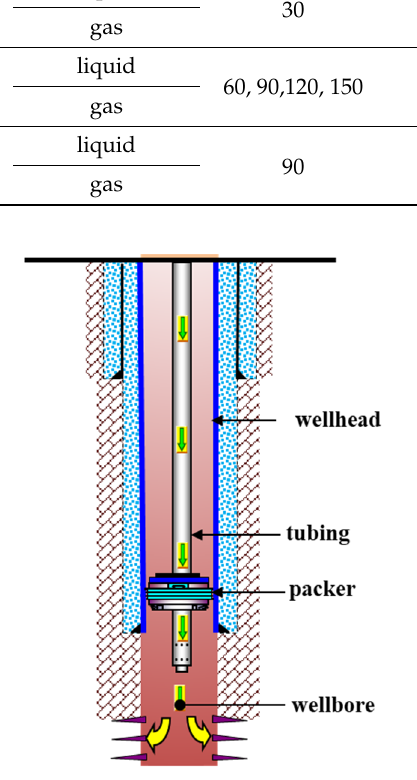
Figure 3. Wellbore, wellbore, and packer structure